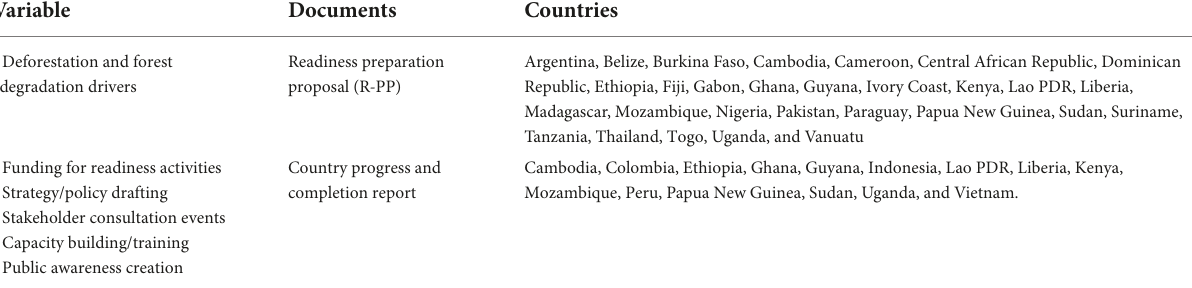
TABLE 1 Summary of FCFP country documents considered for analysis.